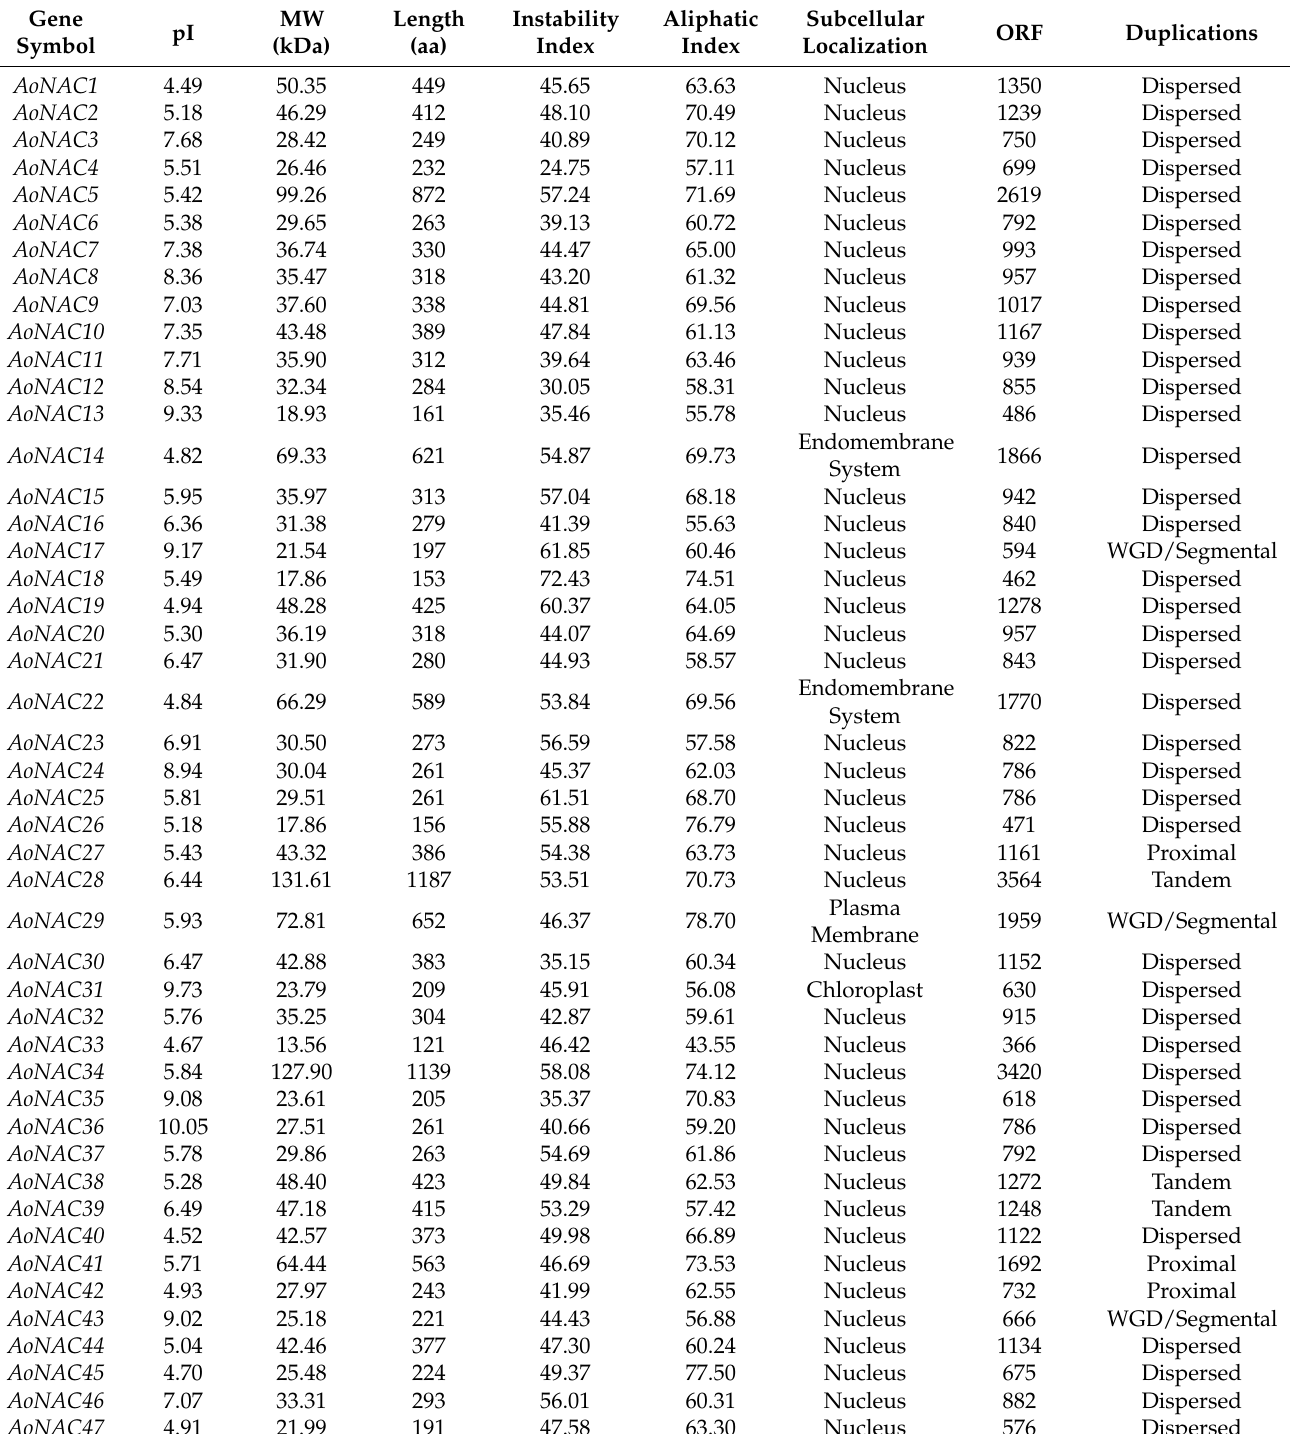
Table 1. Detailed information of NAC genes in A. officinalis